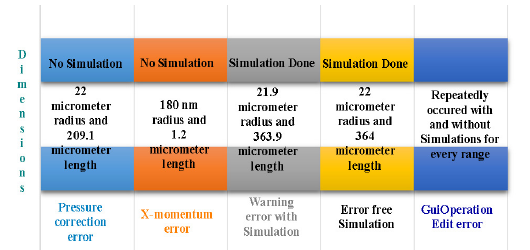
Fig. 16: Contour of pressure for simulation Error free simulation was done for curvilinear microchannel at 9.50 aspect ratio. At these values and beyond error free simulation was done. The summary of this simulation in shown in Fig. 17.